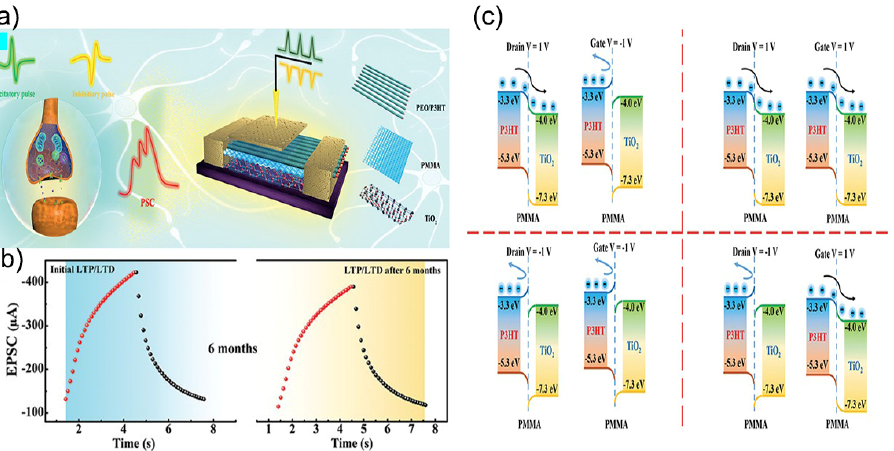
Figure 8. ( a ) Biological synapses and p-i-n JST schematic diagram. ( b ) The potential (30 pulses of 3 V) and inhibition (30 pulses of − 4 V) of p-i-n JST at -1V V D before and after 6 months of exposure to natural environment. ( c ) Schematic diagram of ribbon bending of P3HT/TiO 2 junction under bias voltage. Reproduced with permission from Ref. [57]; published by Wiley-Blackwell, 2021.